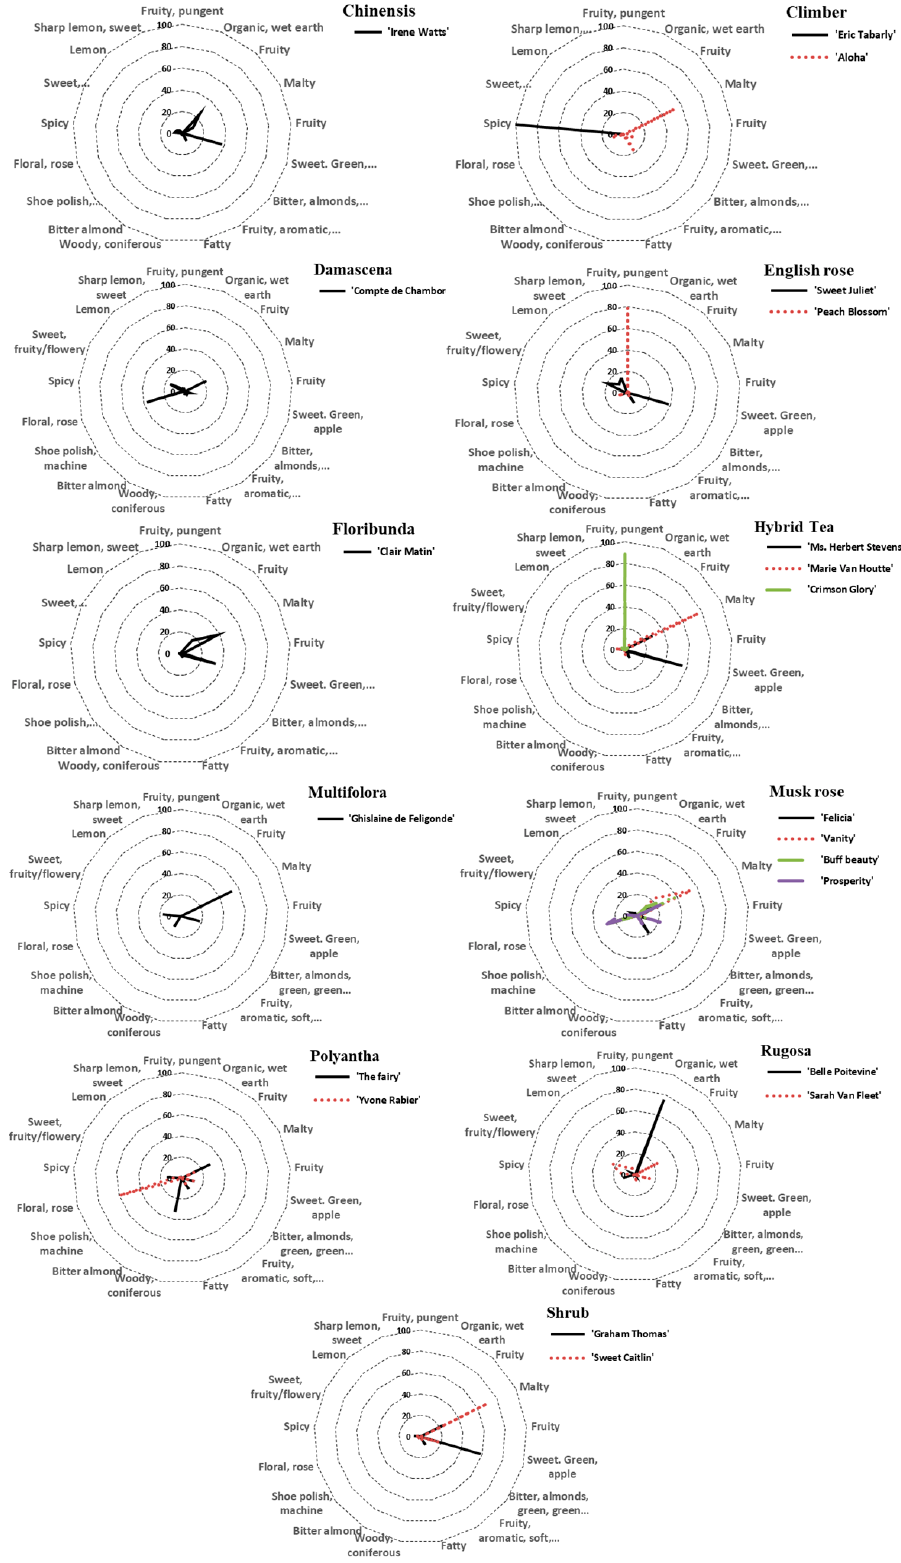
Figure 3. Radar charts showing the percentage (0–100%) of each odor description (see Table 2) within the airless headspace of the pollen of the 21 studied garden rose genotypes. Cultivars were grouped in horticultural classes, as indicated in Table